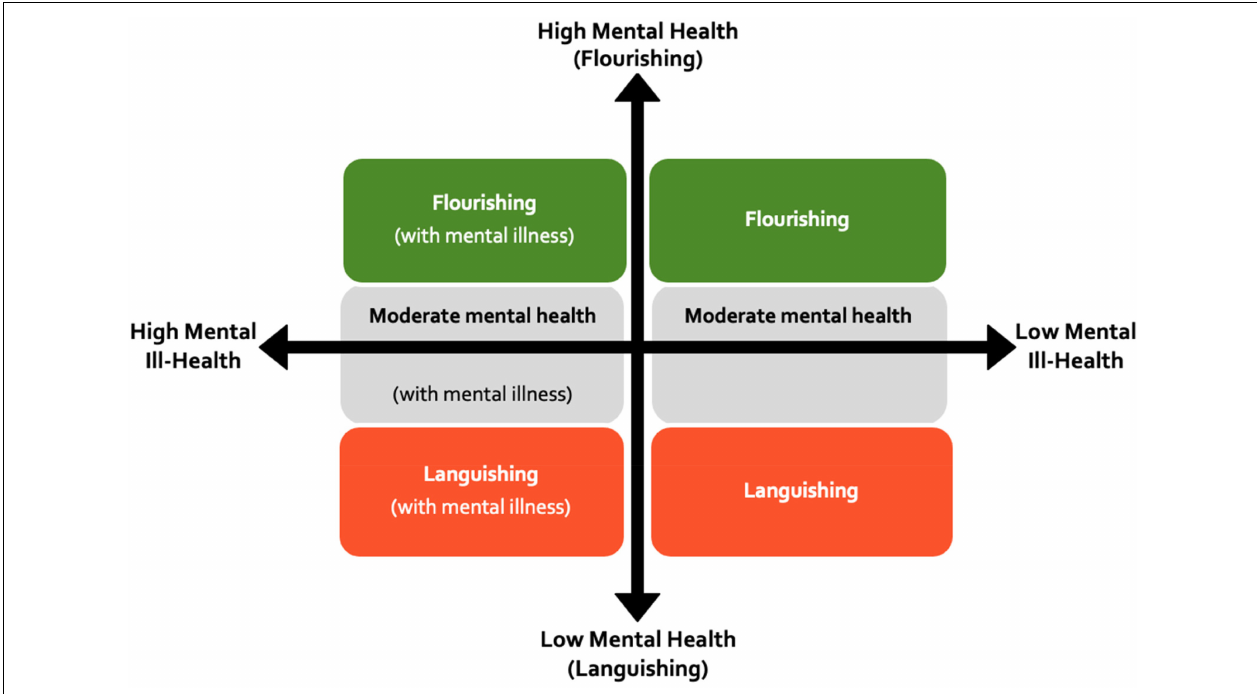
FIGURE 2 | Holistic conceptualization of mental health based on Keyes (2002,